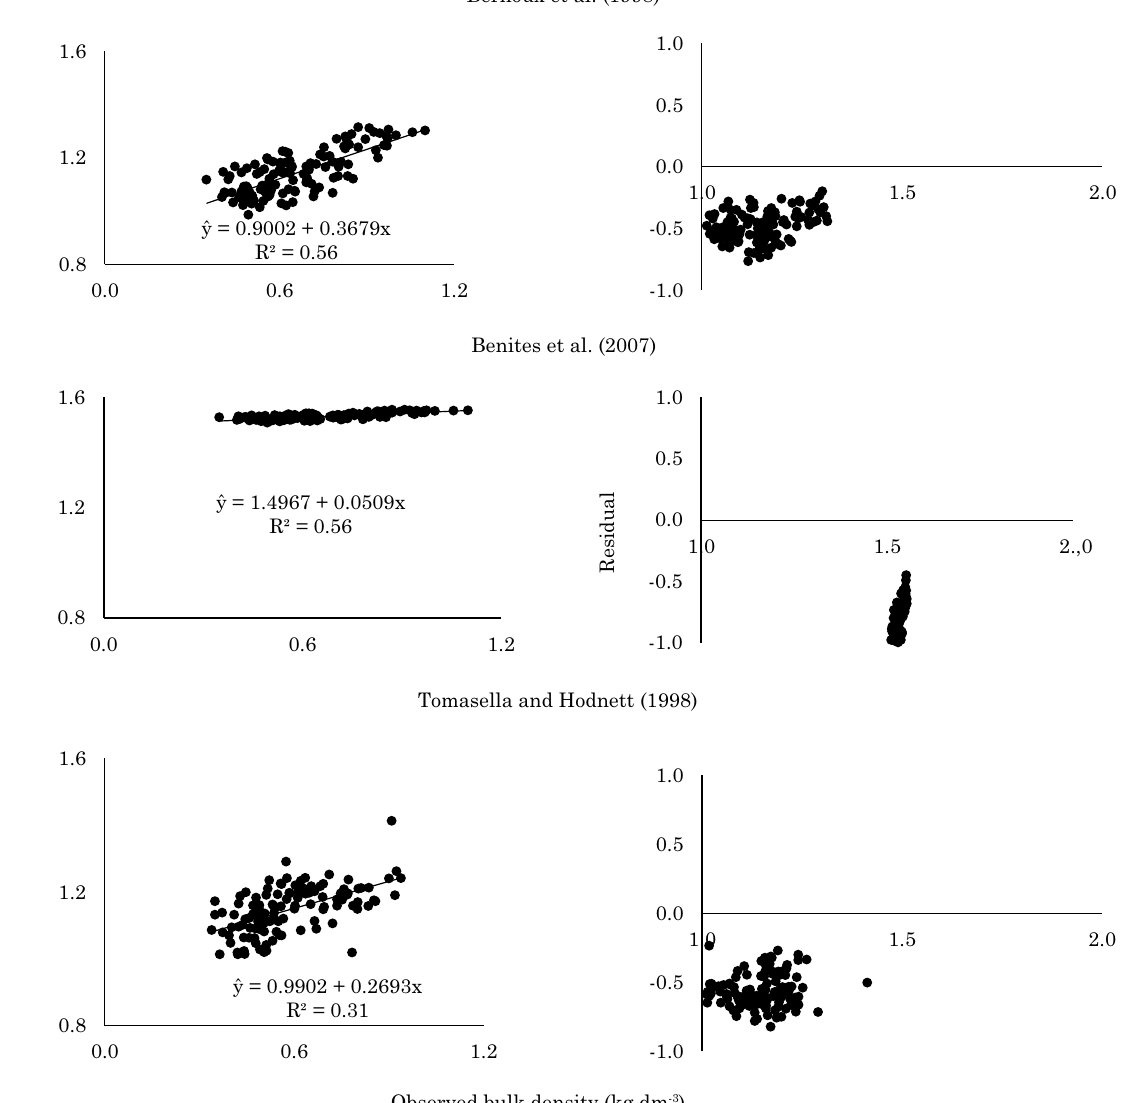
Figure 4. Comparison of our best model with models available in the